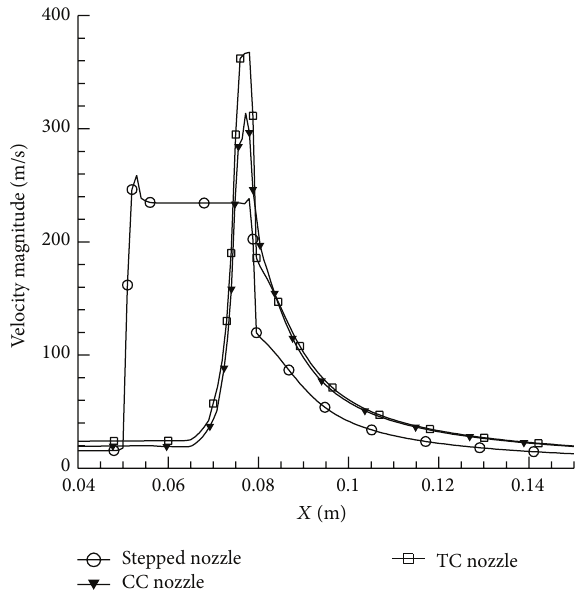
Figure 7: Three different nozzles structure comparison from simu- lation of jet velocity